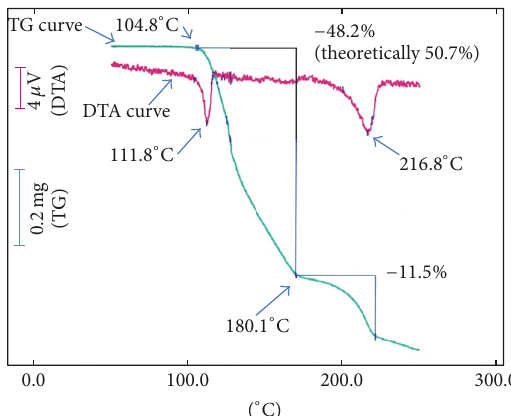
Figure 5: Thermal analysis of Boc-L-Asp ( 5e ). Heating rate: 4.7 ∘ C/min; carrier gas: He, 50 mL/min; AMP range: DTA (differential thermal analysis): 200 𝜇 V, TG (thermogravimetry): 10mg on a platinum cell (2.65 mm × 5.40 i.d.).